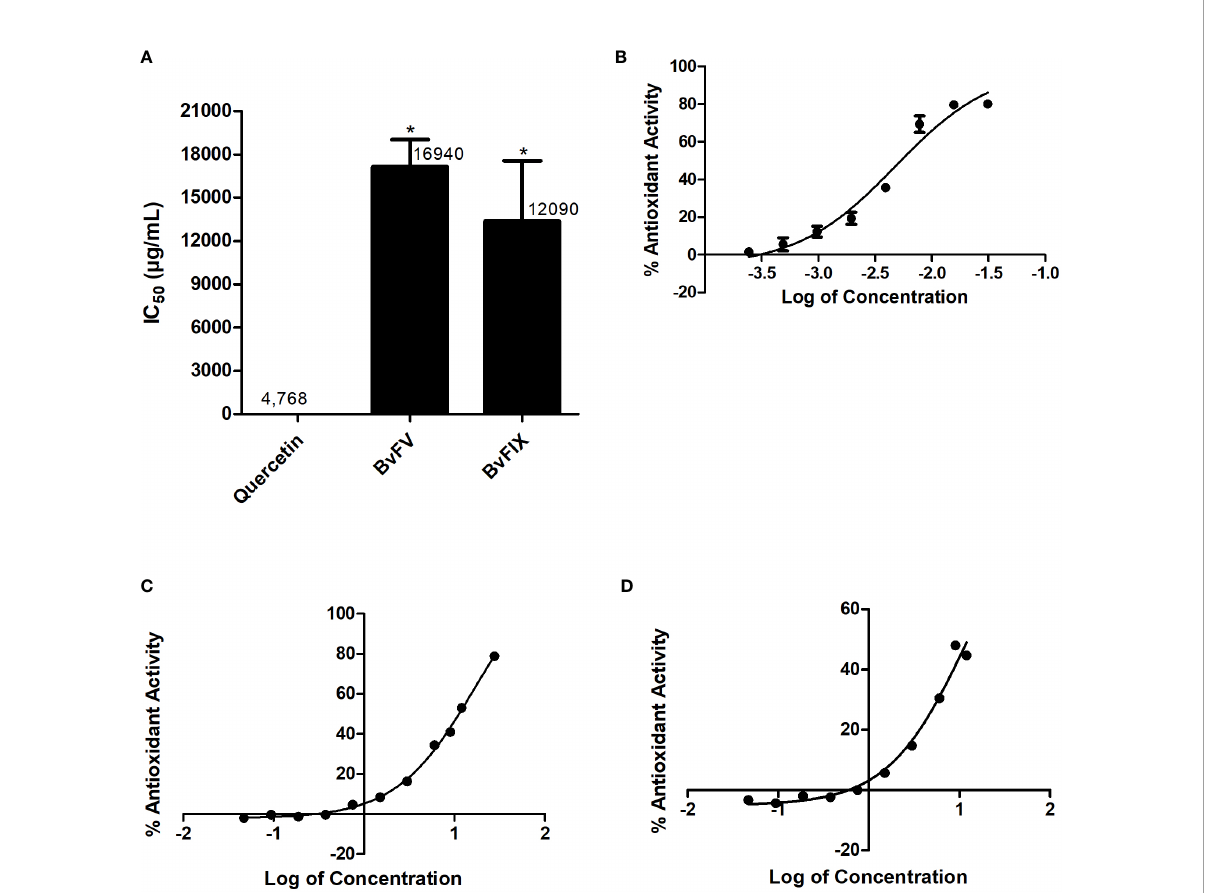
FIGURE 2 Antioxidant activity – determination of IC 50 . The IC 50 value was determined for the extracts using eight different concentrations. A dose vs. response curve was drawn, and the IC 50 value was determined in GraphPad Prism 5. (A) IC 50 , results represent mean ± S.E.M. *, p < 0.05 vs. quercetin, (B) Quercetin dose vs. response curve, (C) BvFV dose vs. response curve, and (D) BvFIX dose vs. response curve. The statistical test applied was the analysis of variance (one-way ANOVA) followed by Turkey ’ s multiple comparison